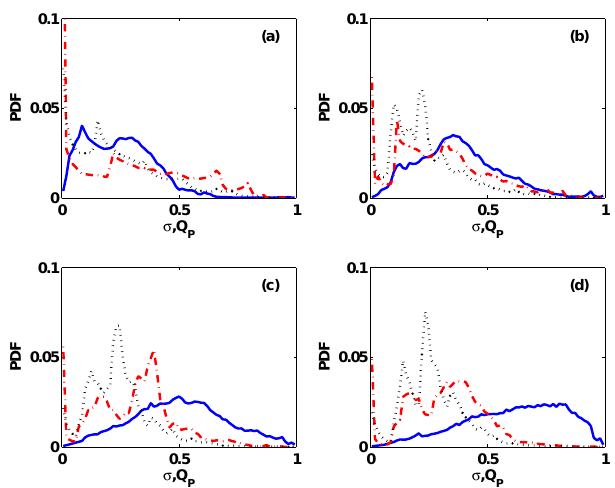
Fig. 3. Probability distribution functions of σ (blue solid line), Q P (red dashed line), and s 2 (black dotted line) for τ = T, 2 T, 3 T and 4 T (a–d) , respectively. All quantities were normalized to one for comparison and PDFs were normalized to have the same unitary area. Set of parameters as in Fig. 1.